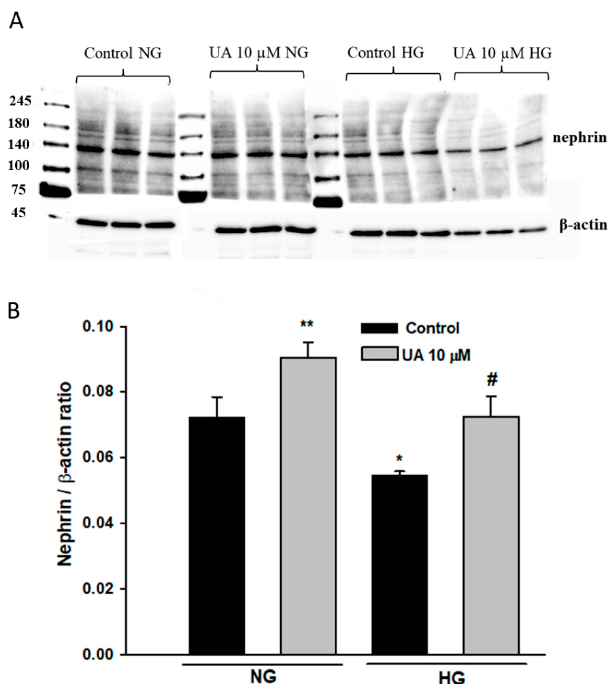
Figure 11. Urolithin A increased total nephrin expression in podocytes. 30-µg protein samples from total cell lysates were subjected to Western blot analysis followed by quantitative densitometric analysis. Nephrin expression in mouse kidney cortex homogenate served as a positive control. A representative immunoblot ( A ). Experiments were performed in triplicate. Results of quantitative densitometric analysis corrected for β -actin show mean ± SEM ( B ). The Student’s t -test was used to calculate p values. * p < 0.05, ** p < 0.01 vs. Control NG, # p < 0.05 vs. Control HG ( n = 3–5).